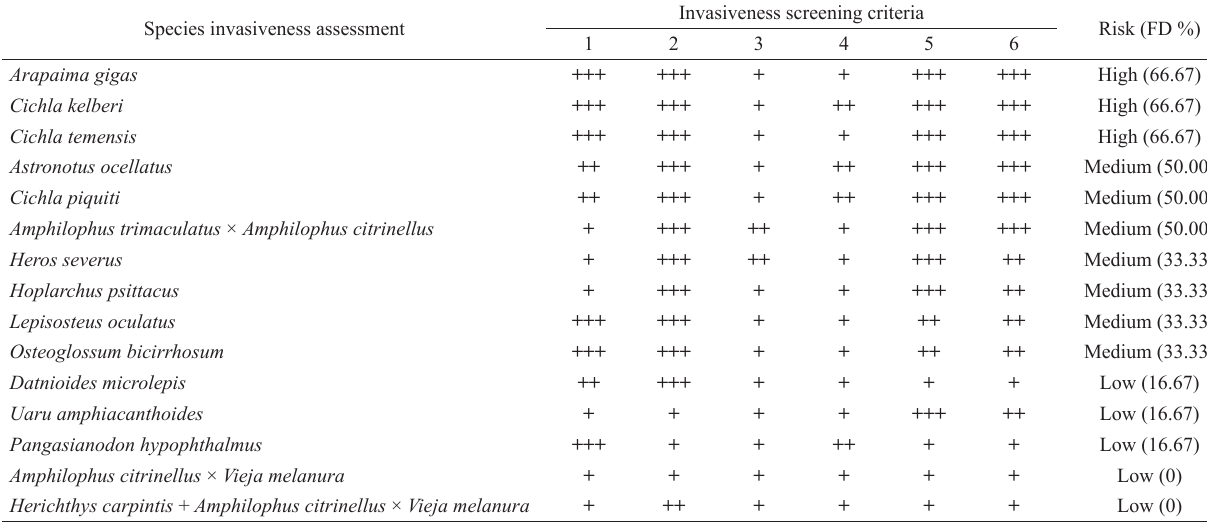
Tab. 2. Results of the Fish Invasiveness Screening Test (FIST) calculated for the 15 most available non-native large fishes. 1: Maximum adult length (cm), 2: Aggressiveness, 3: Tolerance to salinity, 4: History of establishment, 5: Ability to breed in the wild, 6: Competition with native species, +: low; ++: moderate, +++: high. FD% = frequency of +++ among